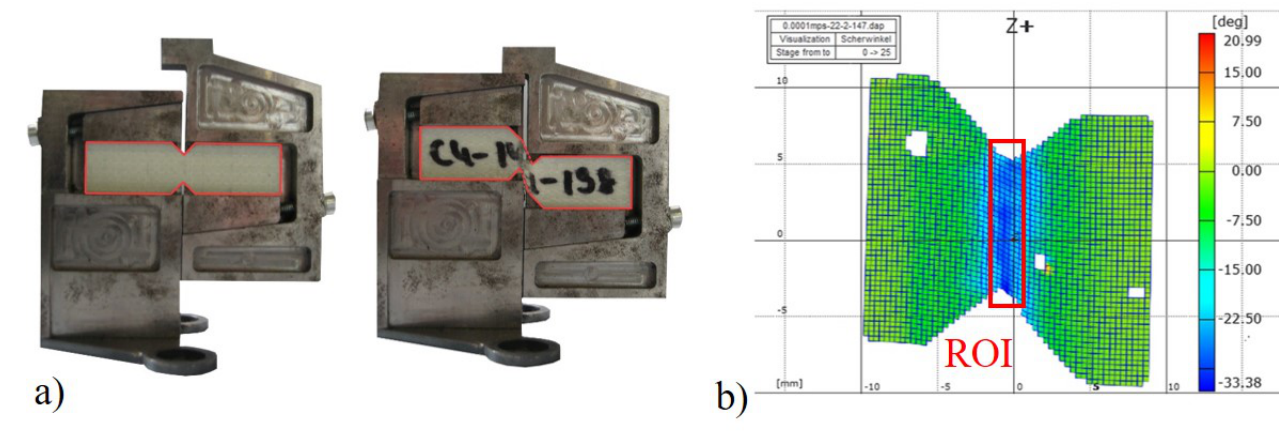
Figure 2. I OSIPESCU shear test setup: ( a ) specimen with undeformed (before) and deformed (after the experiment) specimen; ( b ) representative strain distribution from DIC with the chosen ROI for further